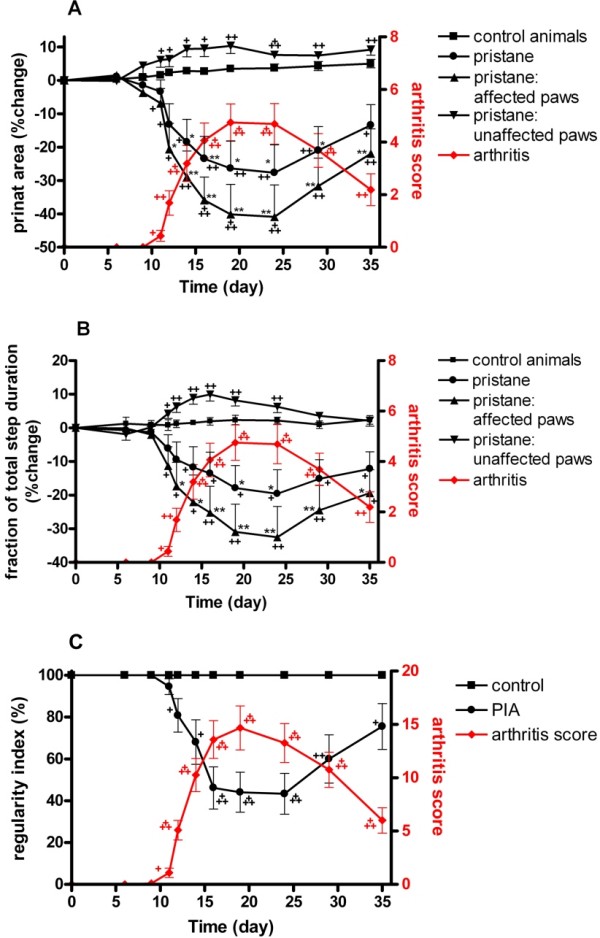
Longitudinal gait analysis of pristane-induced arthritis. Time course of the print area (A) and the stance phase-fraction of total step duration (B) of paws of pristane-injected versus control rats. Mean values obtained for the gait variables of affected (n = 16) and unaffected (n = 8) paws are shown in black. Respective values of all paws of pristane-injected animals (n = 24) are also depicted for comparison. Arthritis scores of affected paws are depicted in red. Mean values ± SEM of paws were calculated and subjected to ANOVA with Dunnett's post hoc test to compare paws of pristane-injected animals with paws of control animals. * P < 0.05, ** P < 0.01. For longitudinal analysis within each group, locomotion and arthritis score was recorded prior to injection and was used as the baseline reading (Day 0). Comparisons with later time points were performed using paired t-tests. + P < 0.05, ++ P < 0.01, +++ P < 0.001. One representative out of two experiments is shown (C) Time course of the regularity index measured by the percentage of normal step sequence patterns in naive control rats (n = 8) and rats injected with pristane (n = 12). Overall arthritis scores of affected animals are depicted in red. The curves show mean values ± SEM. Differences to pre-morbid values were calculated using paired t-tests.